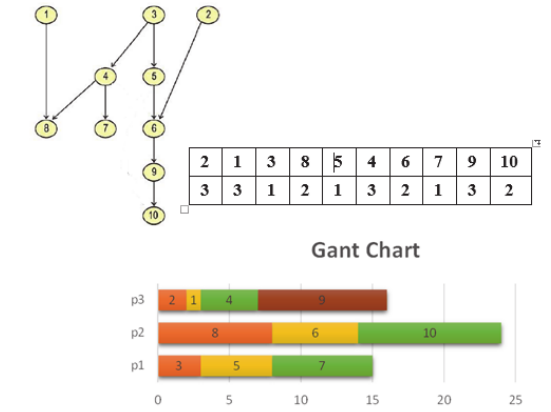
Fig. 3. An example for initial population generation with 8